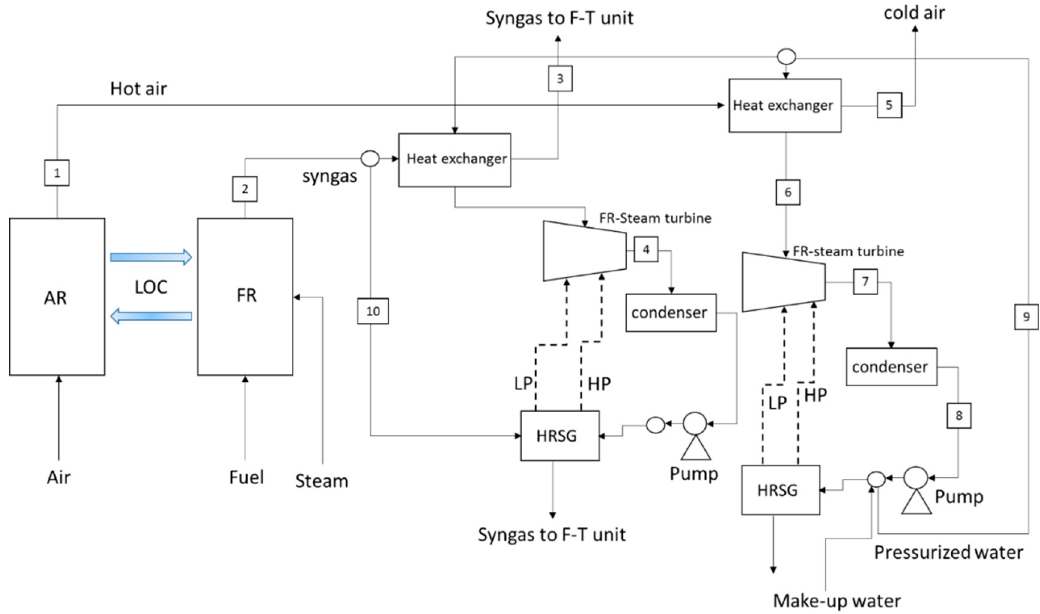
Figure 3. Configuration of the proposed power block to be integrated into an LCLG system (steam turbine combined cycle—STCC).